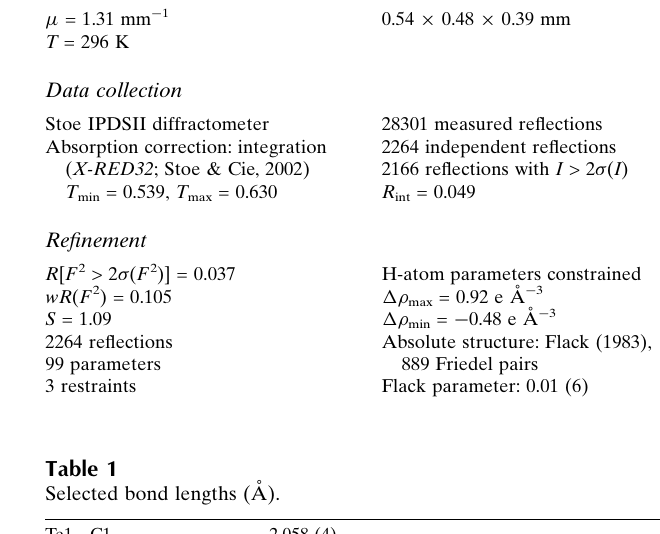
Selected bond lengths (A˚ ).